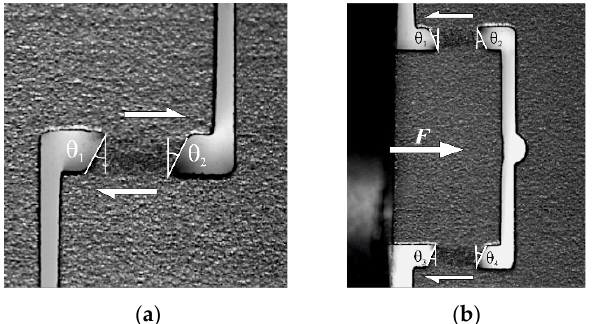
Figure 4. Scheme of maximum shear angles measurement; ( a ) SSS specimen; ( b ) D2S specimen ( θ 1 , θ 2 , θ 3 , θ 4 —max. shear angles).